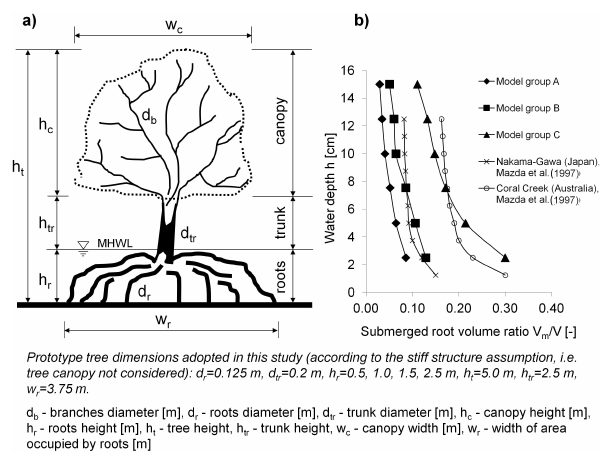
Fig. 1. Geometry of a five-year old Rhizophora apiculata (a) and re- lationship between root density and water depth, obtained for man- grove models from model group A (low root density), B (medium root density) and C (high root density) in reference to field mea- surements by Mazda et al. (1997) (b)